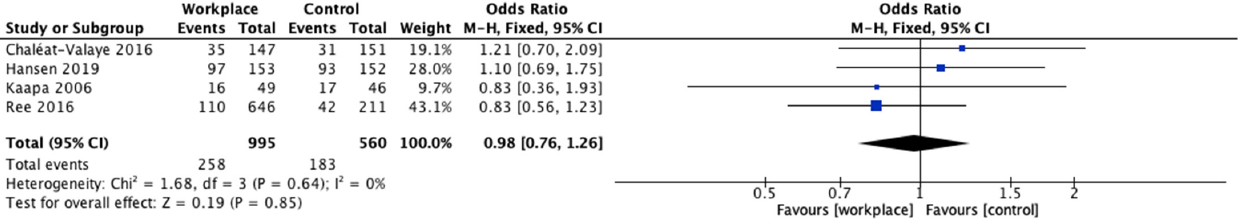
Figure 2. Outcome measurements.